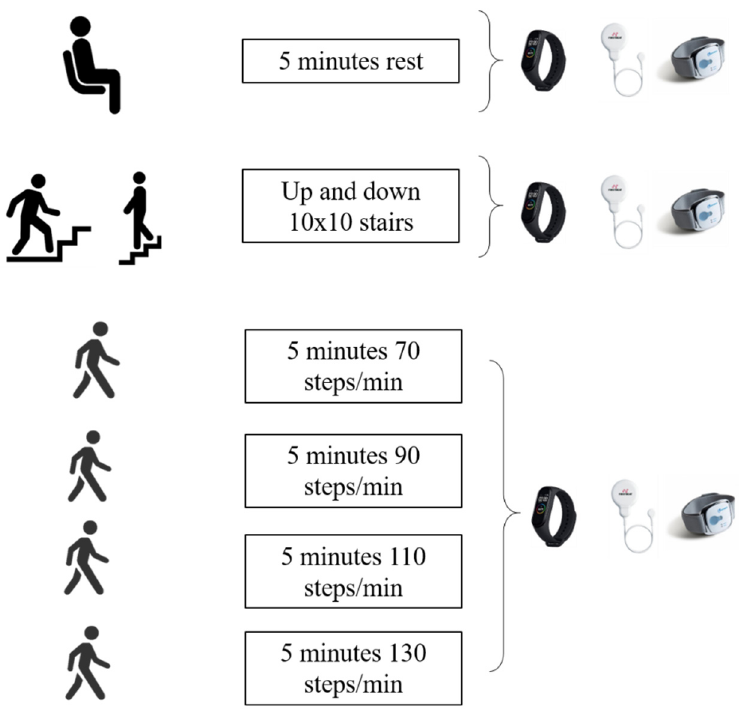
Figure 2. MB4 validation protocol in free-living condition.